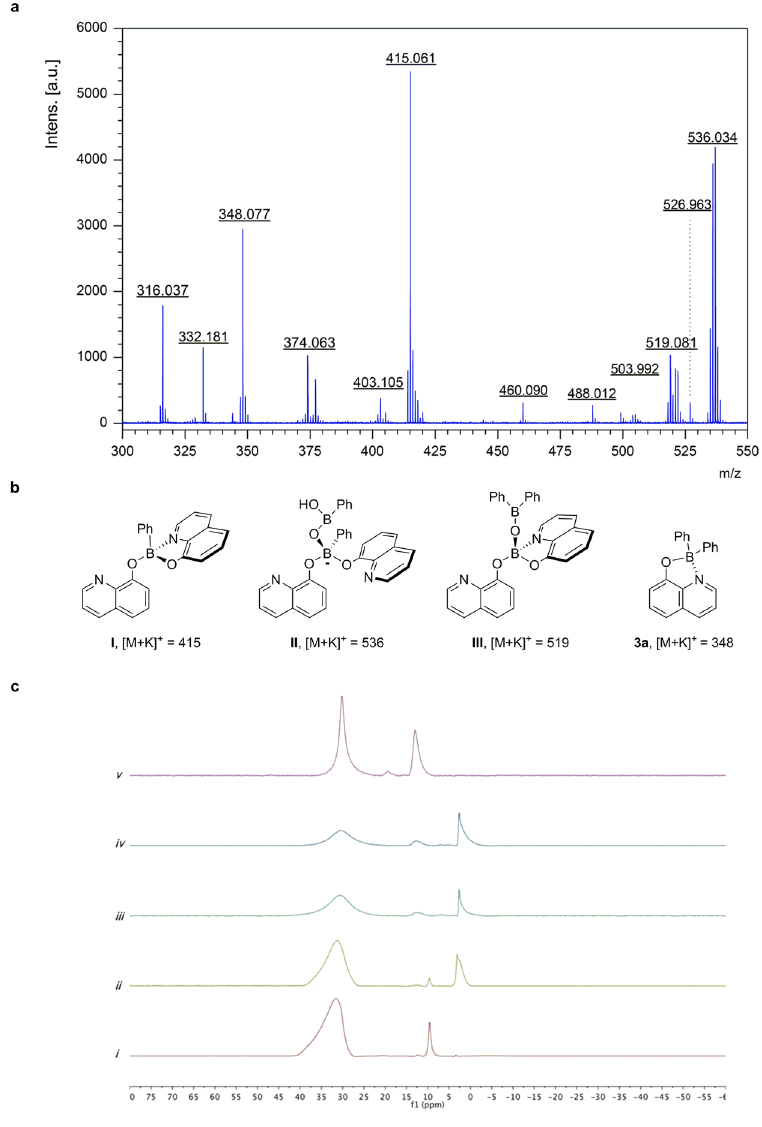
Figure 6. Mechanistic considerations. ( a ) MALDI-TOF mass spectrum obtained from the reaction mixture with base after 6 h. ( b ) Assigned reaction intermediates based on their mass spectral molecular weights. ( c ) 11 B NMR spectra of the reaction mixture taken at different reaction times: without base after 16 h ( i ); and with base after 5 min ( ii ), 3 h ( iii ), 6 h ( iv ) and 9 h ( v ),